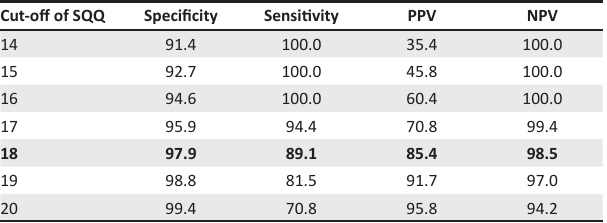
TABLE 3: Psychometric properties of Sleep Quality Questionnaire in screening for insomnia. Cut-off of